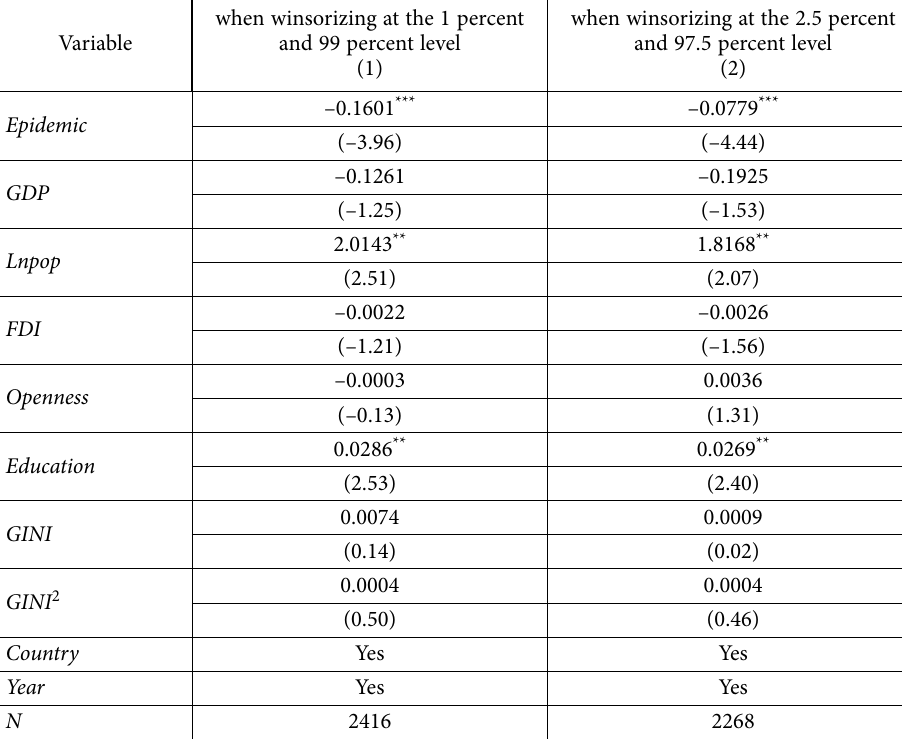
Table 5. Robustness tests: using winsorized data